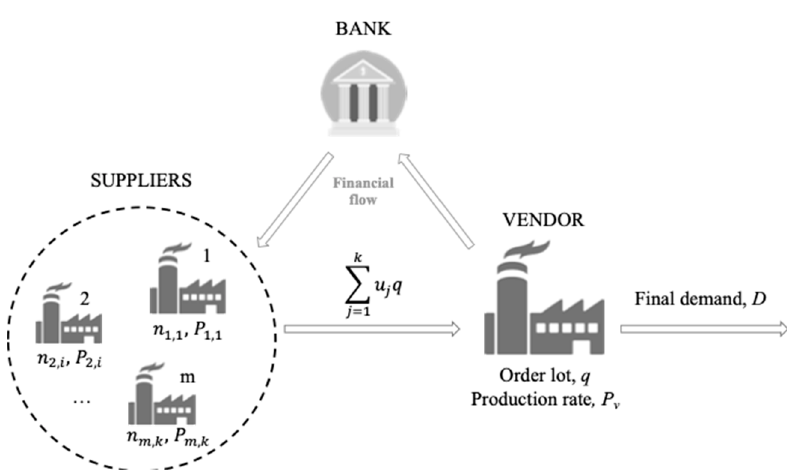
Figure 4. Schematic representation of a supply chain consisting of multi-suppliers, a vendor, and a bank (third party), who manages the financial flows.